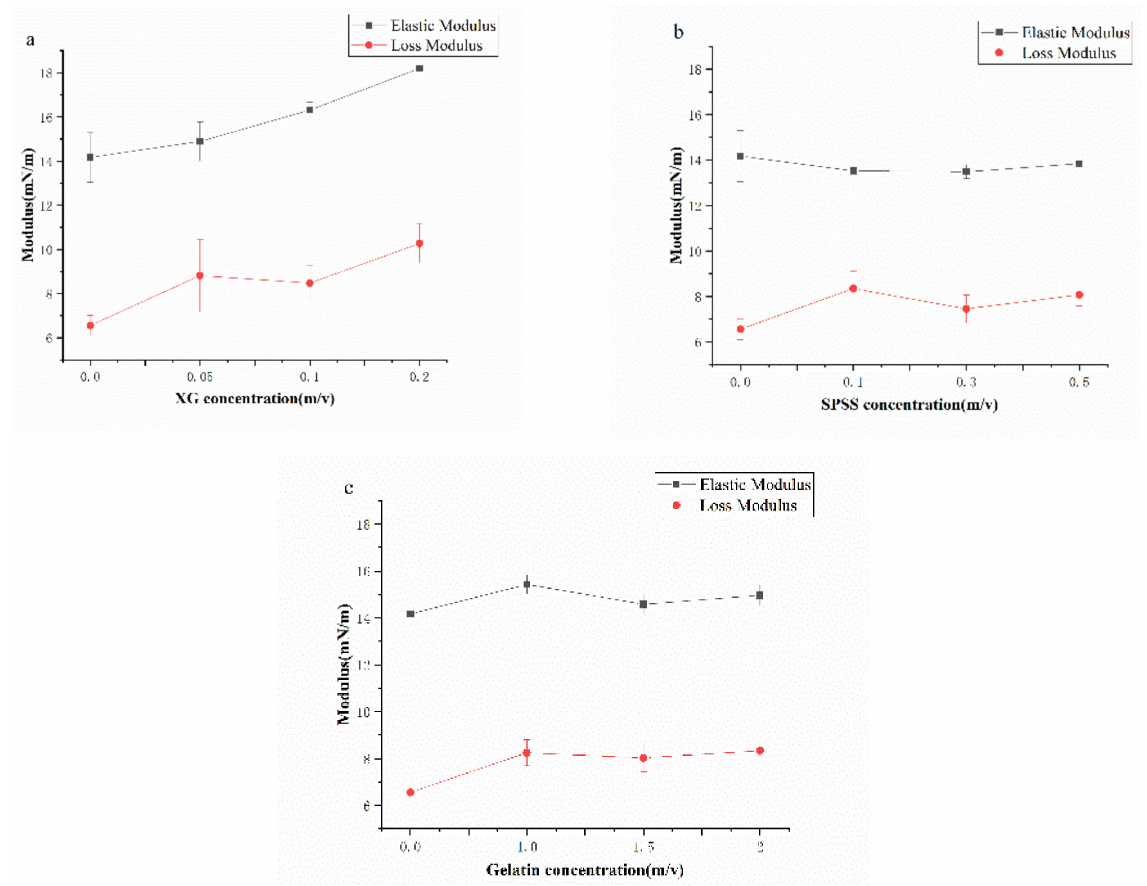
Figure 7. Elastic Modulus and Loss Modulus for samples at the oil–water interface. ( a ) CP-XG; ( b ) CP-SPSS; and ( c ) CP-Gelatin. (CP-Coconut protein, XG-Xanthan gum, SSPS-Soluble soybean